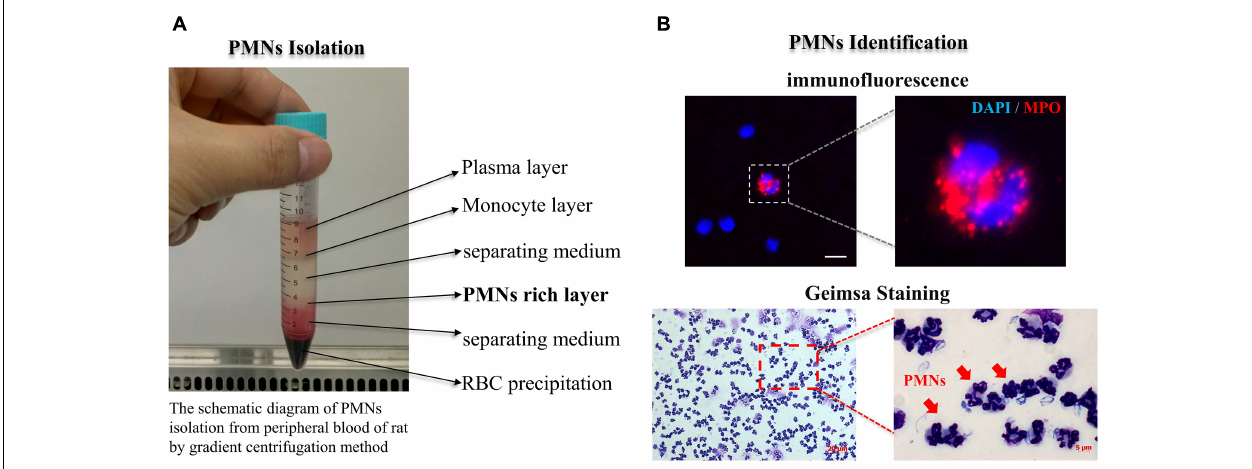
FIGURE 4 | PMNs isolation and identification. (A) The schematic diagram of PMNs isolation from peripheral blood of rat by gradient centrifugation method; (B) PMNs well identified by using immunofluorescence and Giemsa staining methods. PMNs presented the feature typical for PMNs-multilobal nuclei at high magnification. The scaling bar represents 5 µ m in immunofluorescence image.